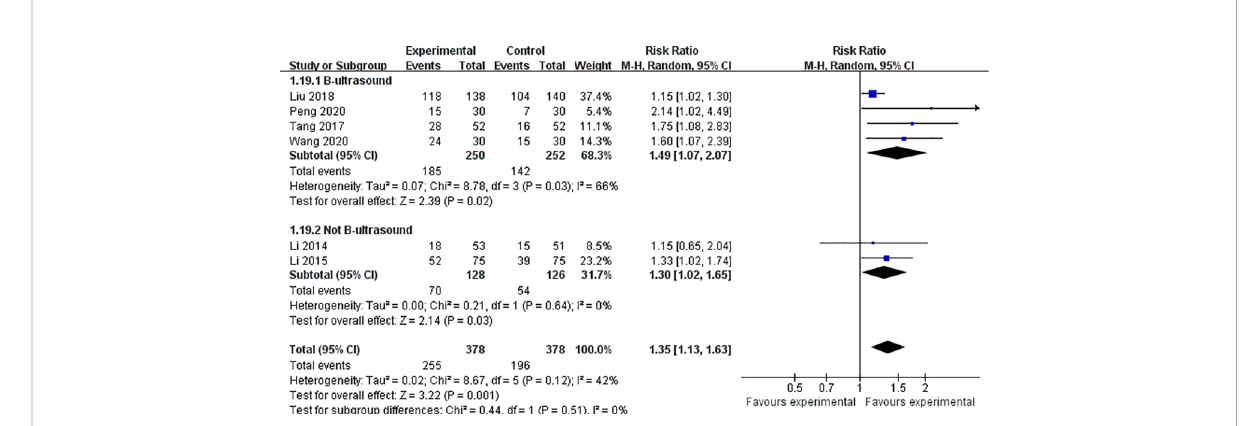
FIGURE 4 Forest plot of effects of acupuncture combined with metformin versus metformin alone on pregnancy rate (diagnostic criteria of pregnancy).